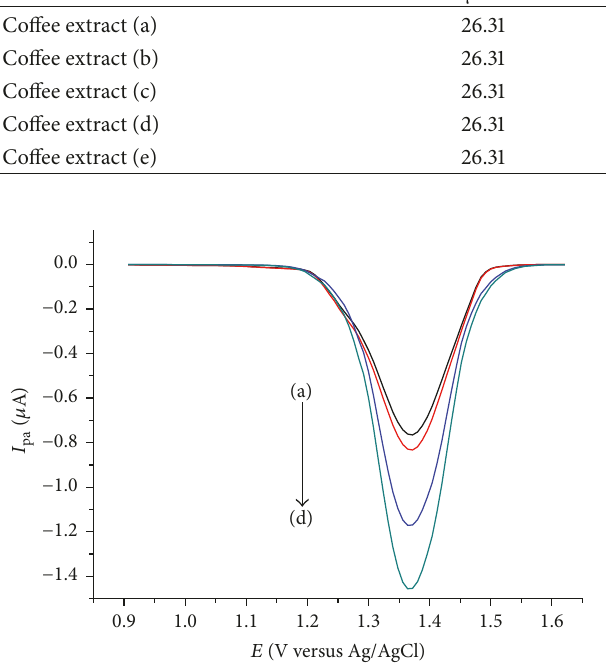
Figure 9: DPVs of aqueous Wolega coffee extract samples spiked with different volumes of 60 𝜇 M of standard caffeine. ((a–e): 0, 2, 3, 6, and 7 mL,